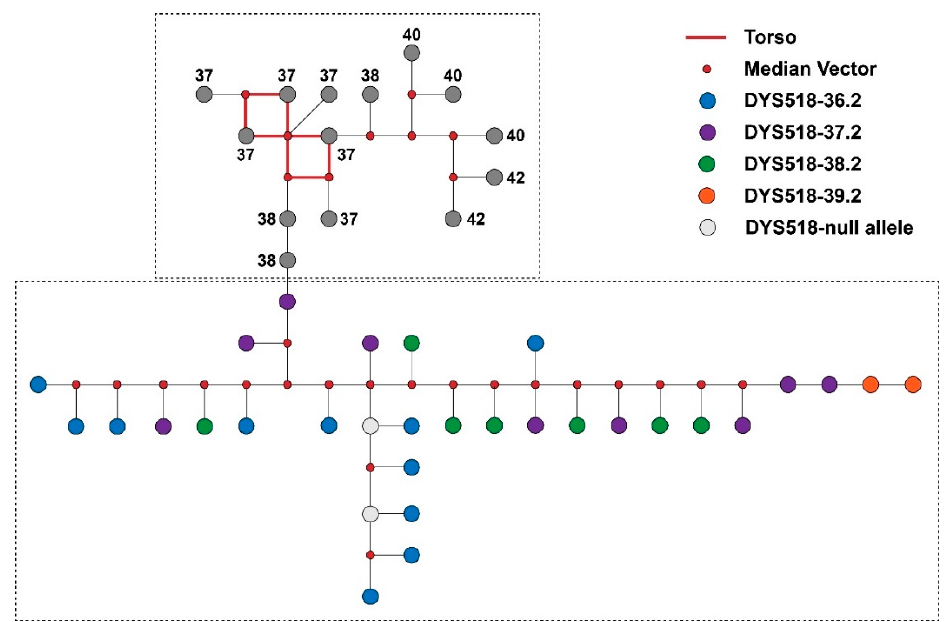
Figure 4. Median-joining network of Y chromosomal short tandem repeats (Y-STR) haplotypes of samples of the haplogroup QR-M45. Blue nodes indicate samples with the DYS518~36.2 variant, purple nodes indicate samples with the DYS518~37.2 variant, green nodes indicate samples with the DYS518~38.2 variant, and orange nodes indicate samples with the DYS518~39.2 variant.